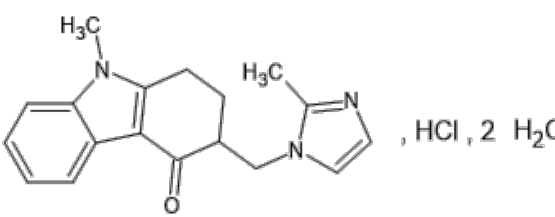
Figure 1. Ondansetron hydrochloride dihydrate—chemical structure.